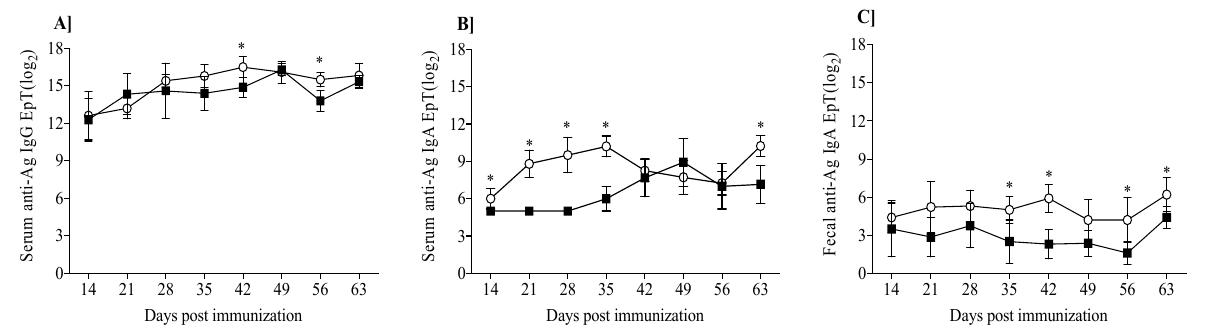
Figure 3. Specific antibody titers induced in mice after immunization with β -lg (black squares) and κ -CN (white circles): ( A ) Serum anti-Ag IgG, ( B ) serum anti-Ag IgA, ( C ) fecal anti-Ag IgA. Each data point corresponds to the mean of the group ± SD. Statistical analysis was performed by t test. Asterisks indicate differences between the two groups at the same data point at p ≤ 0.05.